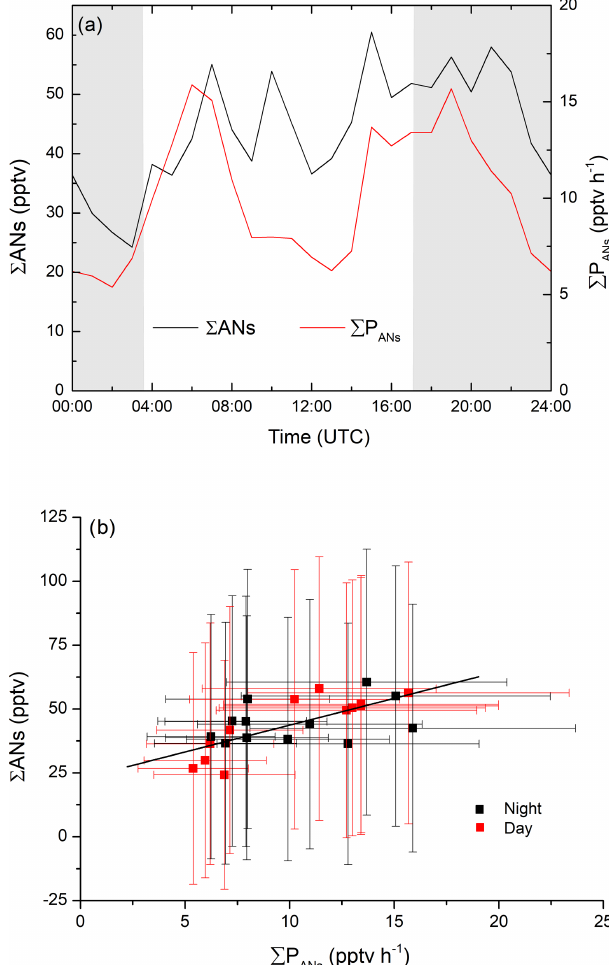
Figure 6. (a) Diel profiles of production rate and mixing ratios of ANs during IBAIRN. (b) Plot of (cid:54) AN mixing ratios versus the to- tal production rate from NO 3 -, OH- and O 3 -initiated VOC oxida- tion during the day (06:00–15:00UTC; black dots) and night-time (18:00–03:00UTC; red dots). The slope of the linear fit to the data (York fit; errors in both axes considered; black line) indicates a life- time of 2 ± 3h. The error bars correspond to the total uncertainty as described in the